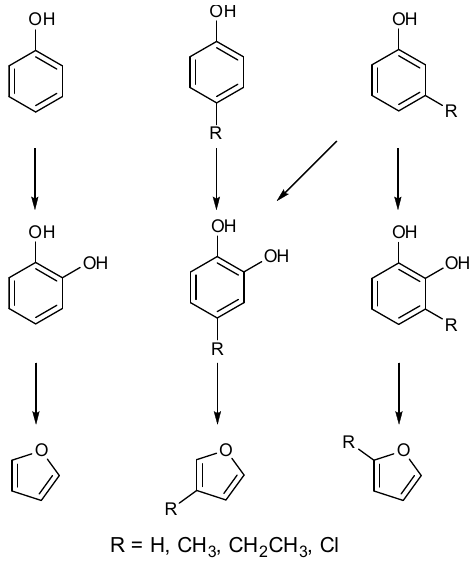
Figure 3. Degradation pathways of phenol and catechol derivatives to furanoic species (Huber et al., 2010) including ethyl moieties.